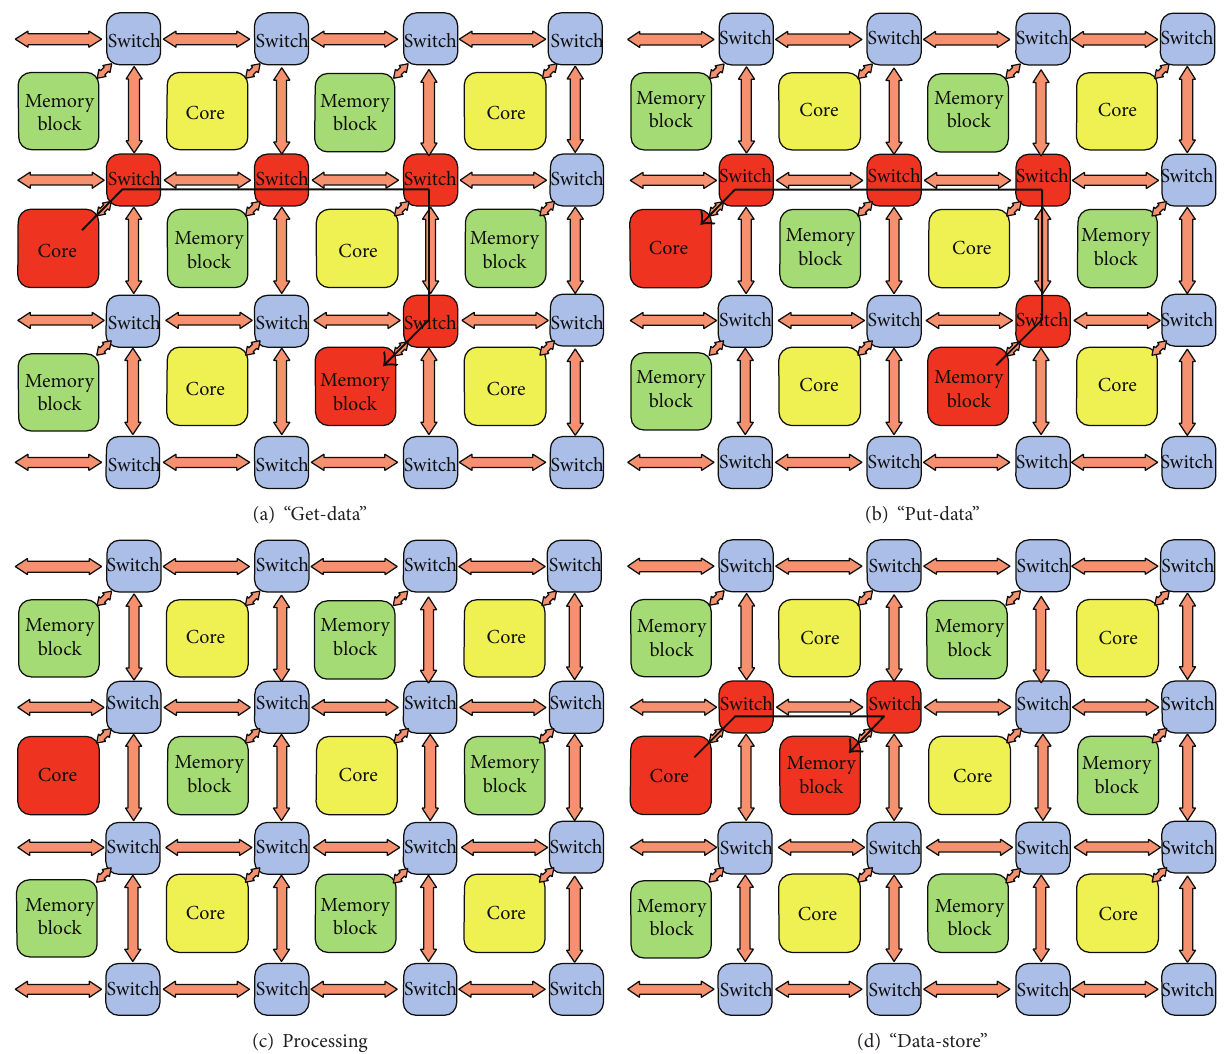
Figure 9: An example of the simulated interaction scenario, started by a NewTaskEvent . For each phase, involved modules are uniformly shaded, and arrows show the information